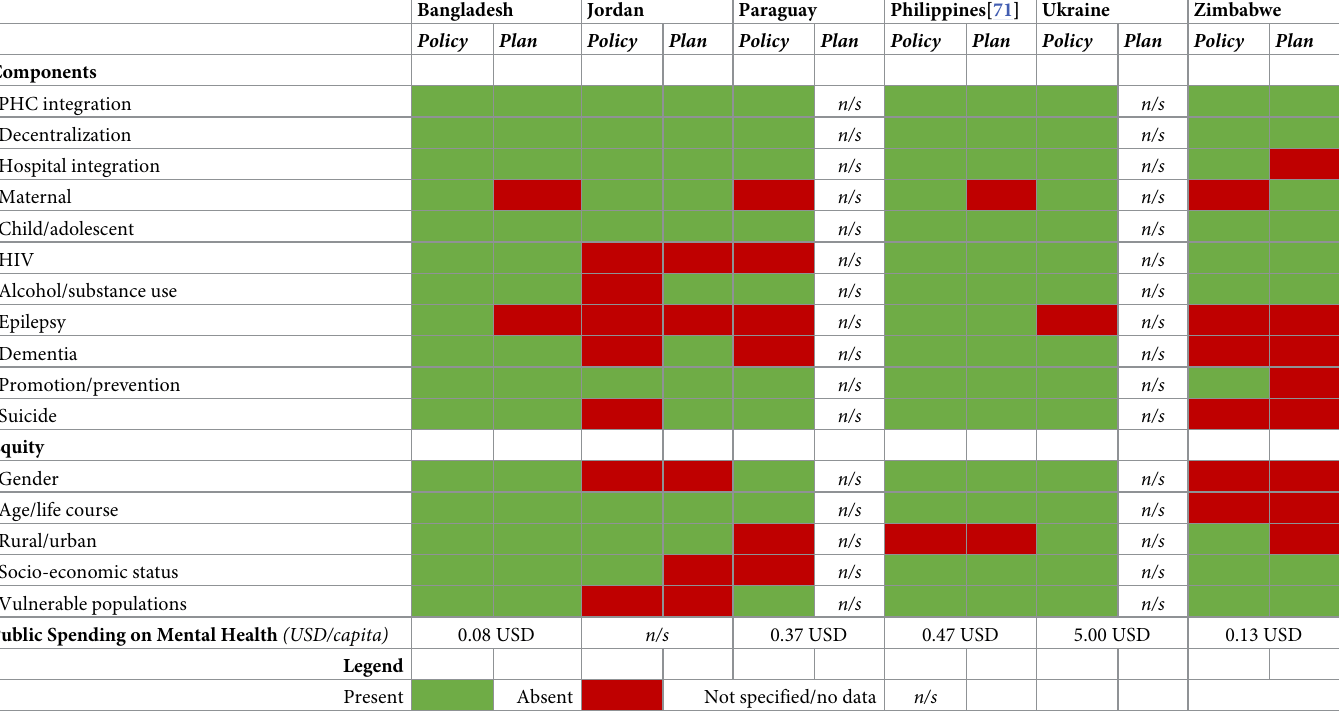
Table 2. Components of national mental health policies and